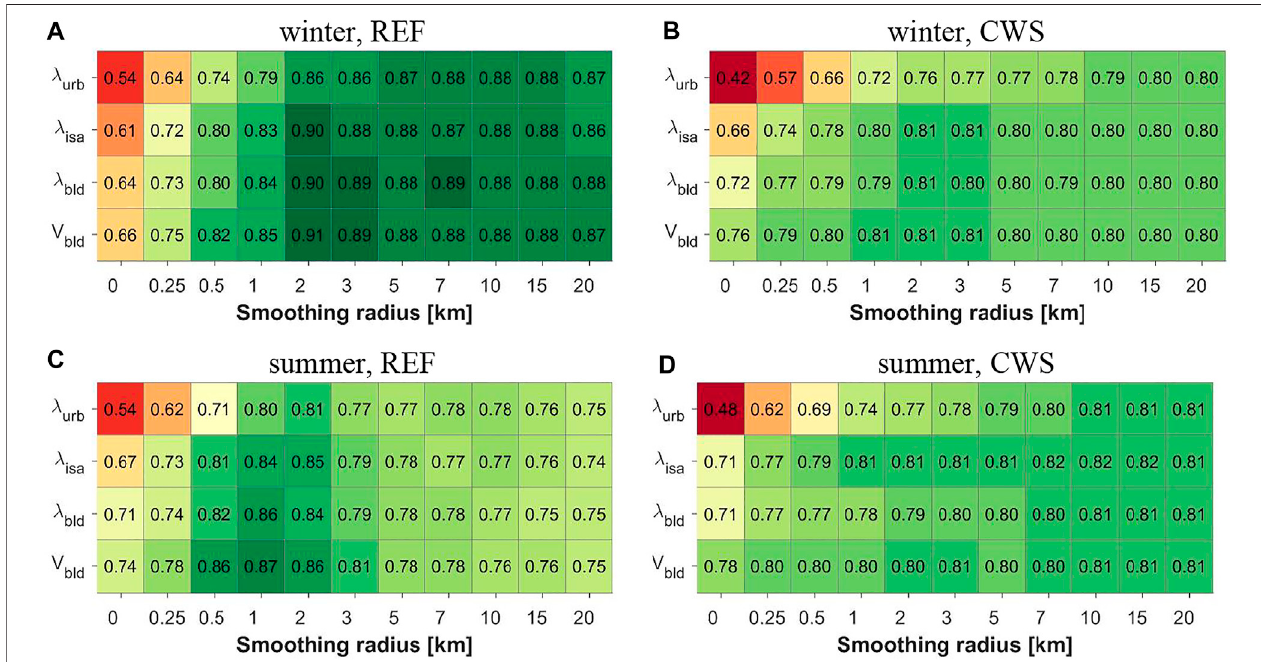
FIGURE 8 | Spearman correlation coef fi cients, calculated between UHI intensity and selected city-descriptive parameters, smoothed with different radii for winter (A,B) andsummer (C,D) periods,REF (A,C), andCWS (B,D) data.Zeroradiusmeansusingthevaluesontheoriginal250-mgrid.Thecolorsofthecellscorrespondto the values.